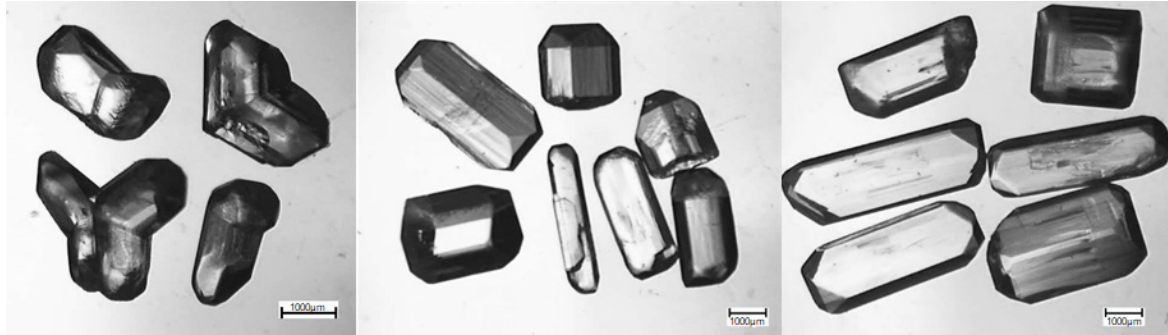
Figure 3. K 2 SO 4 crystals obtained from supersaturated solutions β = 1.25: typical twin crystals observed in this study ( left ), crystals obtained by laser irradiation ( middle ), and crystals obtained by spontaneous nucleation ( right ). Pictures were taken with a NIKON SMZ-10A microscope equipped with a Sony DXC-950 3CCD Color Video Camera Power HAD.